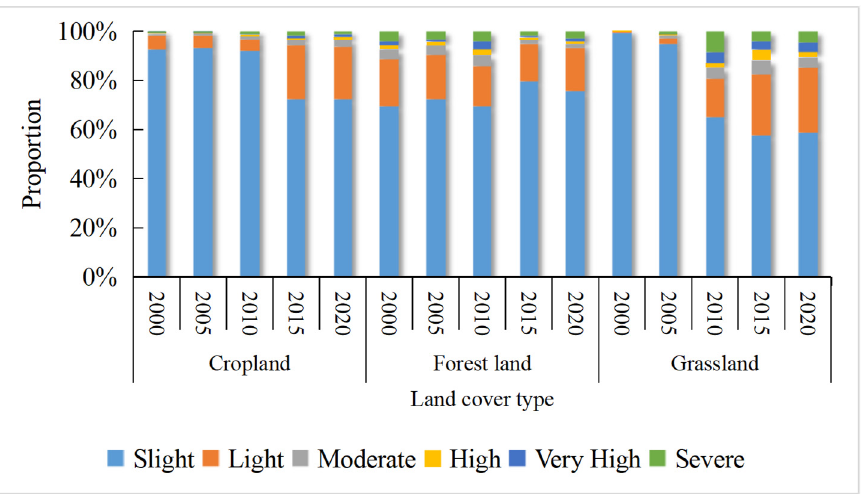
Figure 9. Proportion of area of different soil erosion classes in different land types (cropland, forestland, grassland).